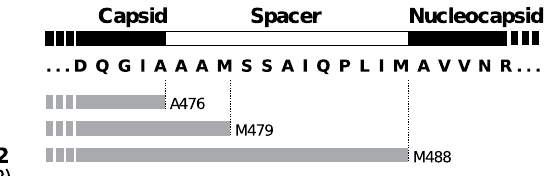
Figure 1. RSV CA variants generated through proteolytic cleavage of the Gag polyprotein. The figure shows the amino acid sequence of the RSV Gag polyprotein (strain Prague C) at the capsid-nucleocapsid junction with the major proteolytic cleavage sites indicated. During maturation, initial cleavage at M488 leads to the transient buildup of the species denoted CA + 12 (CA-SP) 92 . Subsequent proteolytic processing of the spacer peptide yields the species denoted CA and CA + 3, which are found in approximately 2:1 ratio in mature RSV virions 91